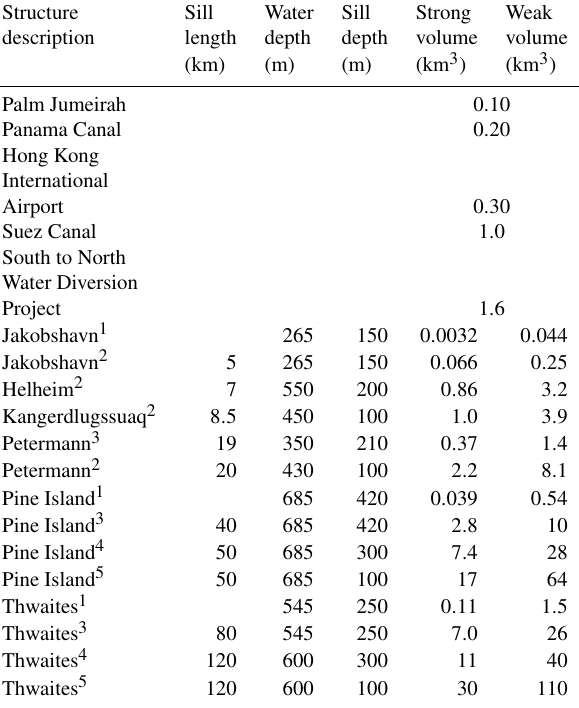
Table 1. Aggregate volume requirements. 1 Isolated pinning points (two for Jakobshavn and PIG, four for Thwaites). 2 Sill built in fjord mouth. 3 Sill under shelf. 4 Low sill in open bay. 5 Tall sill in open bay. For PIG, the sill under the shelf is located on Jenk- ins Ridge, while for Thwaites it is located on the high bathymetry and (relative) lateral constriction around the present-day grounding line. Note that both the 50% water blockage experiment and the 100% water blockage experiment correspond to design (3), with different assumptions about the efficacy of the design for prevent- ing warm water from spilling over into the cavity behind the sill. For all designs, volume calculations assume that the sill is shaped like a triangular prism defined by a fixed angle of repose. Pinning points assume a conical shape with the same angle of repose. “Strong vol- umes” use an angle of repose of 45 ◦ and “weak volumes” use 15 ◦ . Note that the “length” of the sill is the cross-flow dimension of the glacier or fjord. All volumes have been rounded to two significant figures. Palm